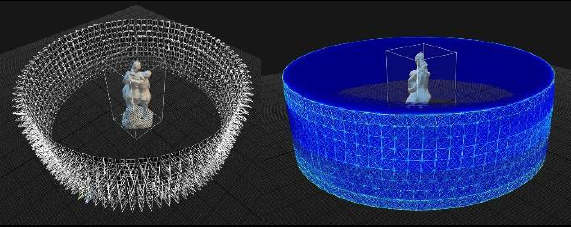
Figure 6. Left: Camera alignment Right: Network of image ties.